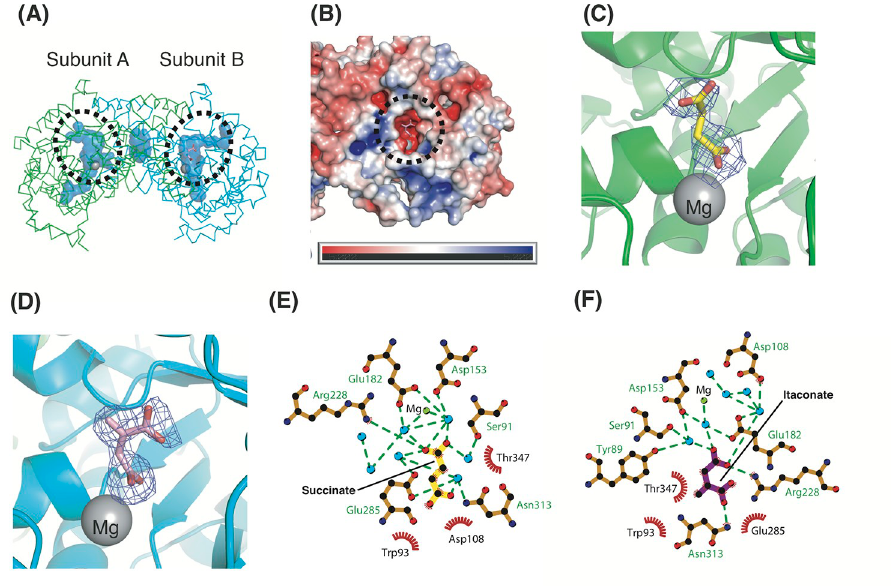
Fig 2. Active site structure of tbICL in complex with succinate and itaconate. (A) Cavities including active sites are colored blue. The dashed ovals indicate active sites. (B) Surface electrostatic potential of tbICL. The scale bar ranges from − 5 kT/e (red) to 5 kT/e (blue). The dashed circle indicates the active site in subunit B. Omit maps of succinate (C) and itaconate (D). The omit maps ( F O − F C ) of succinate and itaconate are colored blue and contoured at the 2.0 sigma and 3.0 sigma level, respectively. Diagrams of succinate (E) and itaconate (F) interactions in the active sites. They interact with water molecules (blue circles) and neighboring residues.